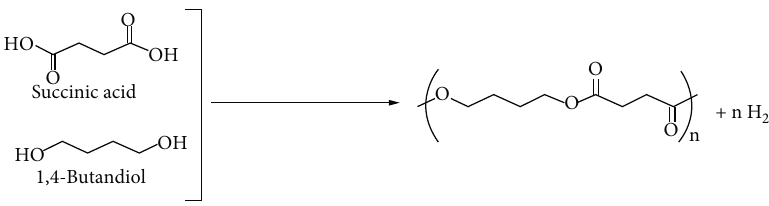
Figure 9: Poly(butylene succinate) synthesis reaction.